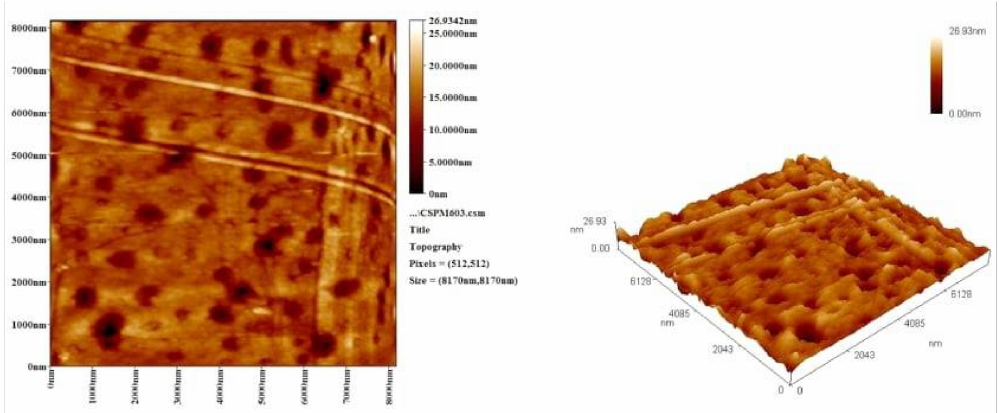
Figure 7. AFM images of PVC containing Schiff base 1 film after 120 min of thermal degradation at 180 ◦